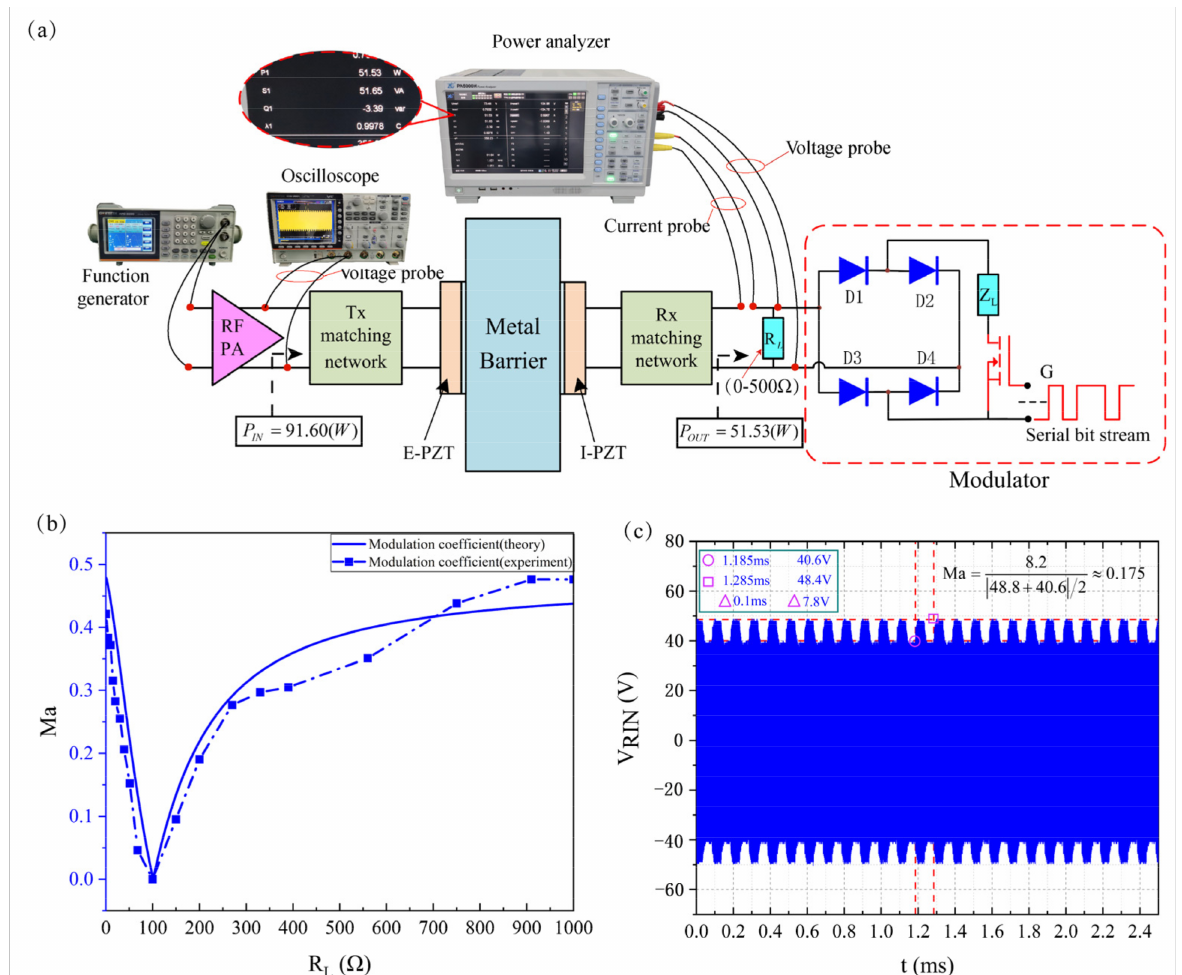
Figure 8. Application of the optimal method. ( a ) Measurement system configuration. ( b ) Compar- ison of experimental and theoretical values of modulation coefficient after SCIM. ( c ) Modulated carrier